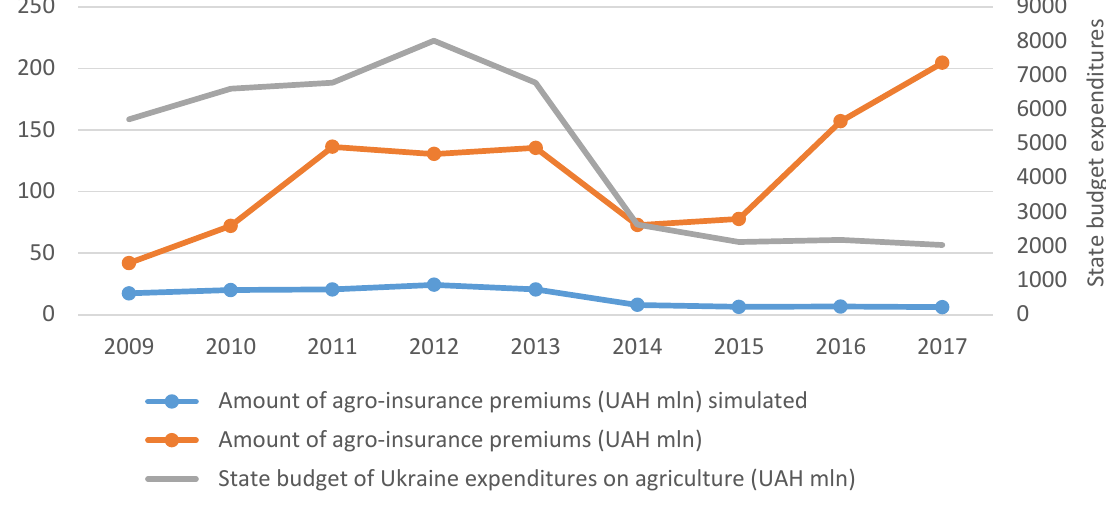
Figure 6. Dynamics of changes in the real and simulated levels of agricultural insurance as to public financing of the